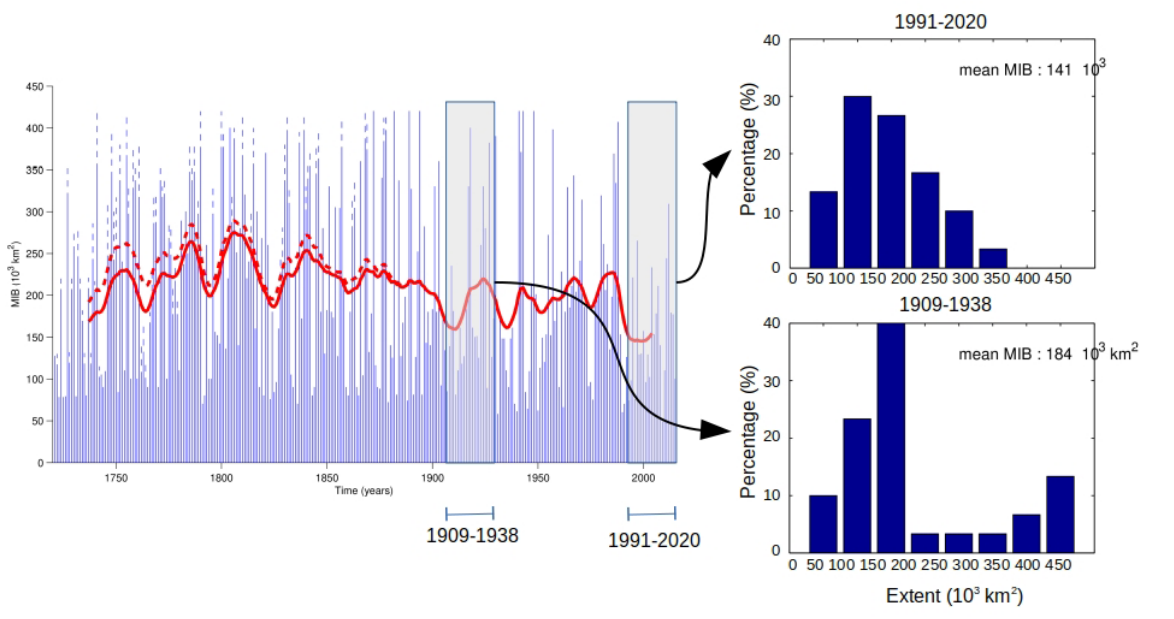
Figure 14. The graph on the left shows the annual maximum sea ice extent of the Baltic Sea (MIB) in kilometres squared (km 2 ) during 1720– 2020. Blue bars show the annual mean, and red lines show the 15-year running means. The dashed bars represent the error range of the early observations (Vihma and Haapala, 2009). The error range of the 30-year moving average is indicated by two red curves, which converge into one when high-quality data became available. The graphs on the right show the 30-year distribution functions of MIB during 1909– 1938 and 1991–2020. Data sources: https://www.eea.europa.eu/data-and-maps/daviz/maximum-extent-of-ice-cover-3#tab-chart_1 (last ac- cess: 17 February 2022); Finnish Meteorological Institute (https://en.ilmatieteenlaitos.fi/ice-season-in-the-baltic-sea, last access: 17 Febru- ary